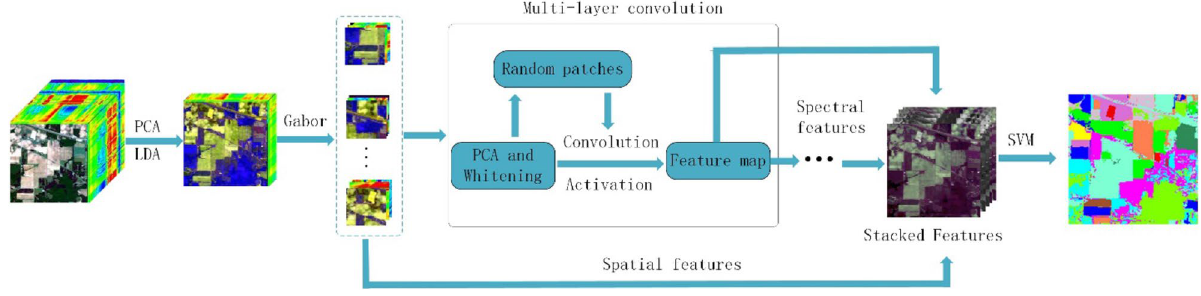
Figure 1. The method flow chart of this